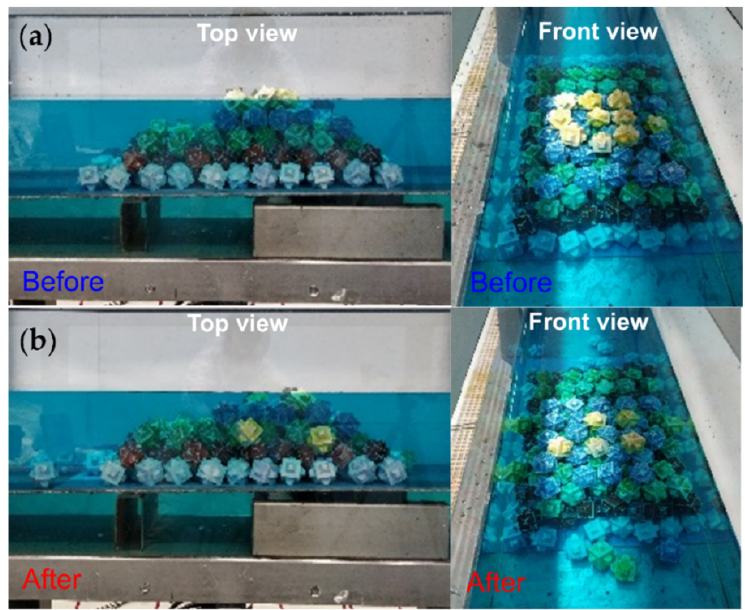
Figure 5. Initial and final stages of the structure before and after the interaction of the breaking incident waves: ( a ) top and front views of the initial shape of the structure; ( b ) top and front views at the end of the experimental test.